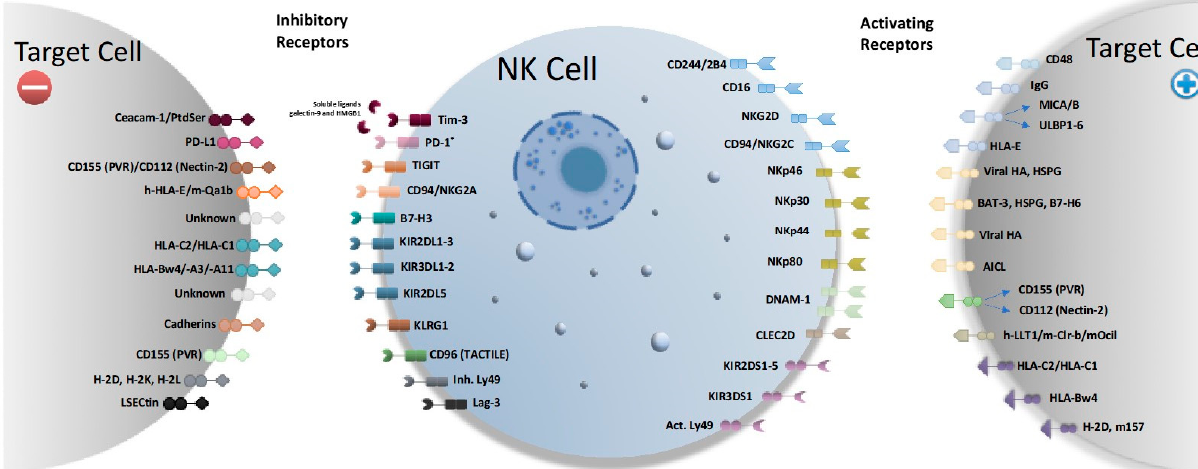
Figure 1. Activating and inhibitory NK cell receptors present in mice and humans. Abbreviations: PVR—polio virus receptor, HL—human leukocyte antigen, KIR—killer-cell immunoglobulin-like receptor, NKG2A—natural killer group 2A, NKG2D—natural killer group 2D, NKG2C—natural killer group 2C, DNAM-1—DNAX accessory molecule-1, LLT1— lectin-like transcript-1, HA—hemagglutinin, MICA/B—MHC class I chain-related protein A and B, ULBP-1—UL16 binding protein 1, AICL—activation-induced C-type lectin, PtdSer—phosphatidyl serine, Tim-3—T-cell immunoglobulin and mucin domain 3. Ceacam-1—carcinoembryonic antigen-related cell adhesion molecule 1, HMGB1—high-mobility group box 1, LSECtin—lymph node sinusoidal endothelial cell C-type